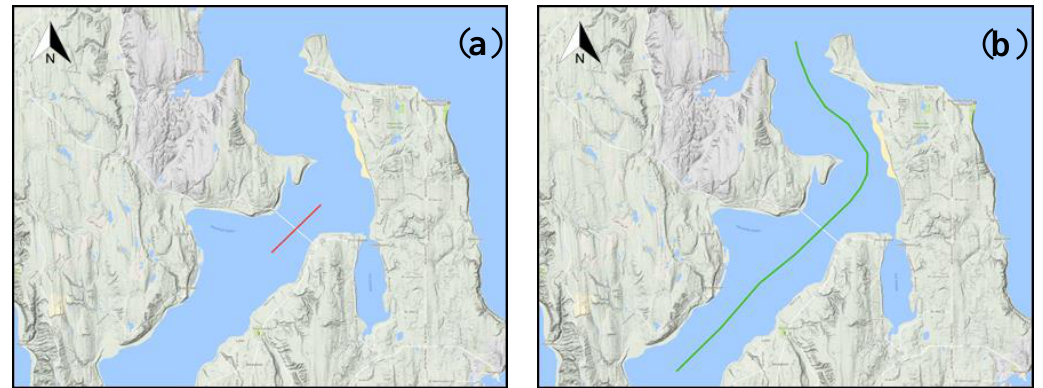
Figure 17. Transects for assessment of zone of influence (ZOI) in a vertical plane: ( a ) short transect for near-field effects; ( b ) longer transect to examine the effects over full tidal excursion.